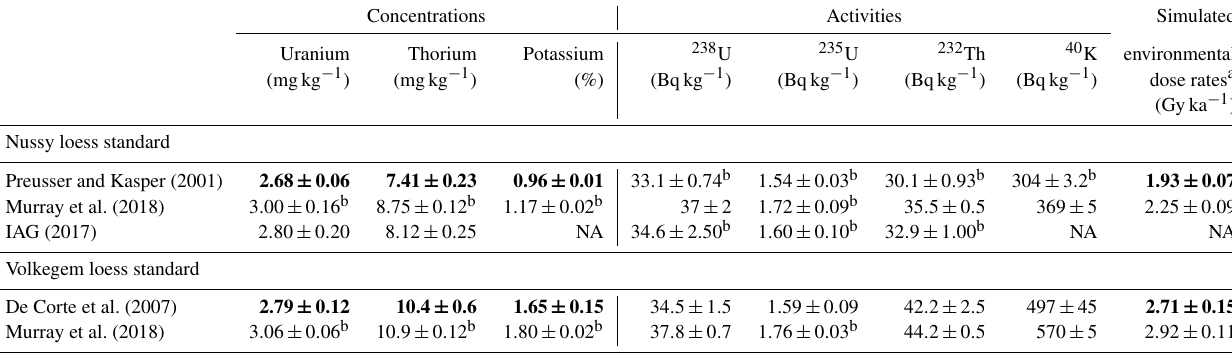
a Values in this column represent simulated environmental dose rates calculated for the 90–200µm grain size fraction of HF-etched quartz using the Dose Rate and Age Calculator DRAC v1.2 (Durcan et al., 2015). All calculations are based on the radionuclide concentrations provided in this table, applying the dose rate conversion factors given by Guérin et al. (2011). Please note that a constant water content of 15 ± 5 % and a constant contribution of 0 . 150 ± 0 . 015Gyka − 1 arising from cosmic radiation were assumed for all calculations. We would like to point out that these assumed values do not correspond to the values that might actually be determined for Nussy and Volkegem sampling sites. Therefore, the calculated dose rates are referred to as “simulated environmental dose rates” in the table and in the text. b Values converted from radionuclide concentrations to activities and vice versa were calculated using conversion factors and natural uranium composition given by Guérin et al. (2011). All calculations were verified by applying the radionuclide-specific conversion factors provided in Table 2.5 of IAEA